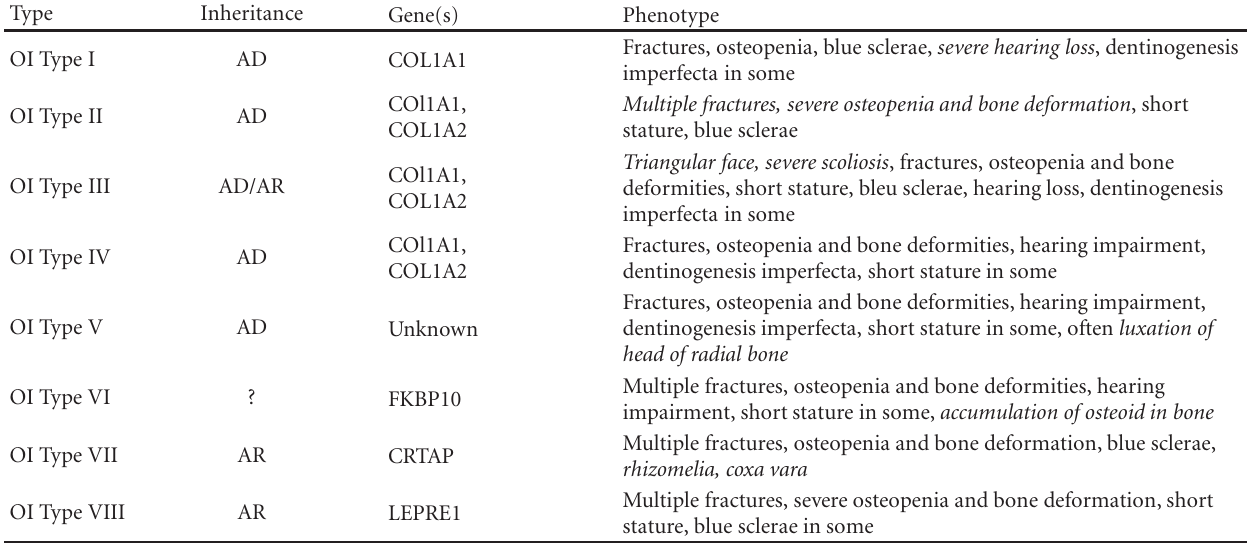
Table 2: Silence classification of osteogenesis